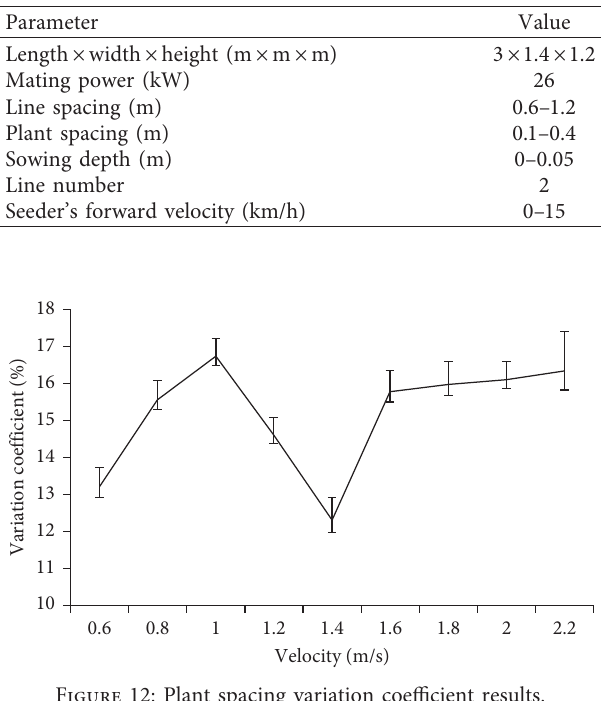
Table 1: Technical parameters of combined air suction cotton